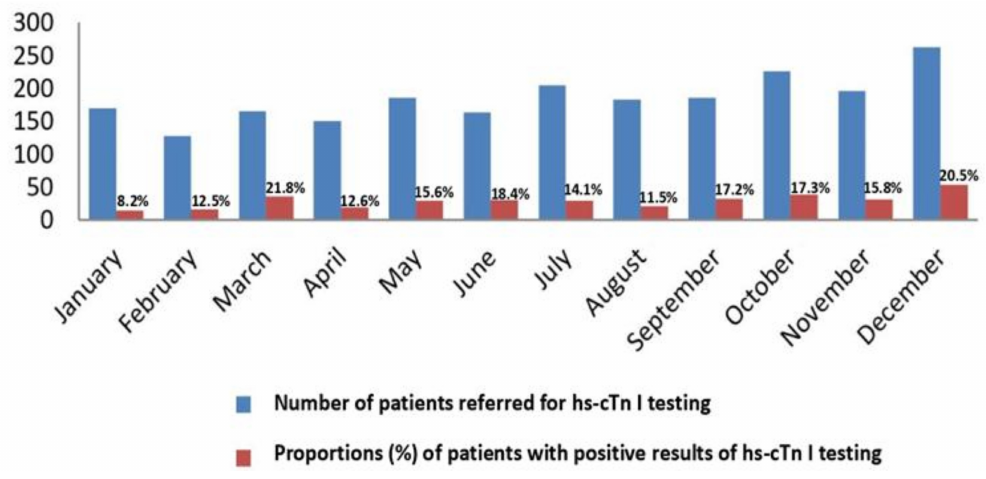
Figure 1. Proportions (%) of positive results of the hs-cTn I test relative to the number of requests. A distribution by months. Table 1. The hs-cTn I test repetition rates.